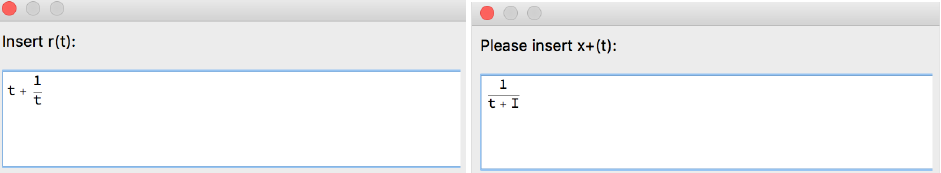
Figure 59. Output given by the [SInt] 2.0